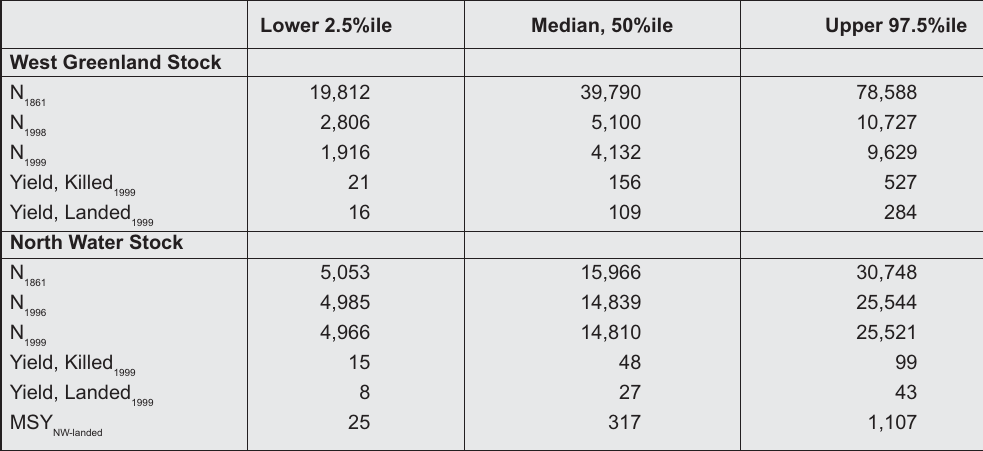
Table 3 . Yield estimates from SIR simulations for the West Greenland and North Water stocks of beluga. 200,000 simulations, 1,515 non-zero likelihoods. N = estimated population size, N timated carrying capacity, MSY = maximum sustainable yield.